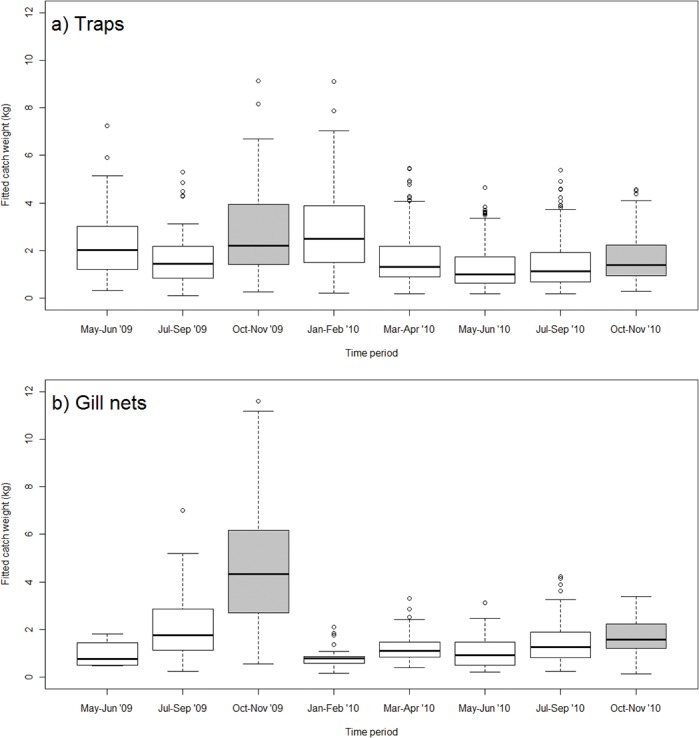
Temporal variation in catch weight.Fitted catch weight for the top model based on lowest AIC for each gear type. Box and whisker plot of modelled catch weight per trip in kilograms for a) trap fishers and b) gill net fishers over the study period; the horizontal bar represents the 50th percentile, the top of the box the 75th percentile, and the base of the box the 25th percentile. Whiskers represent the range of data, and open circles are outliers. Catch weights are largest in Jan-Feb for trap fishers and in Oct-Nov for gill net fishers. Time periods with smallest catch weight are May-Jun and Jul-Sep for trap fishers and Jan-Feb for gill net fishers. Grey shading refers to the proposed earlier closed period; the current closed period is not represented in the data.